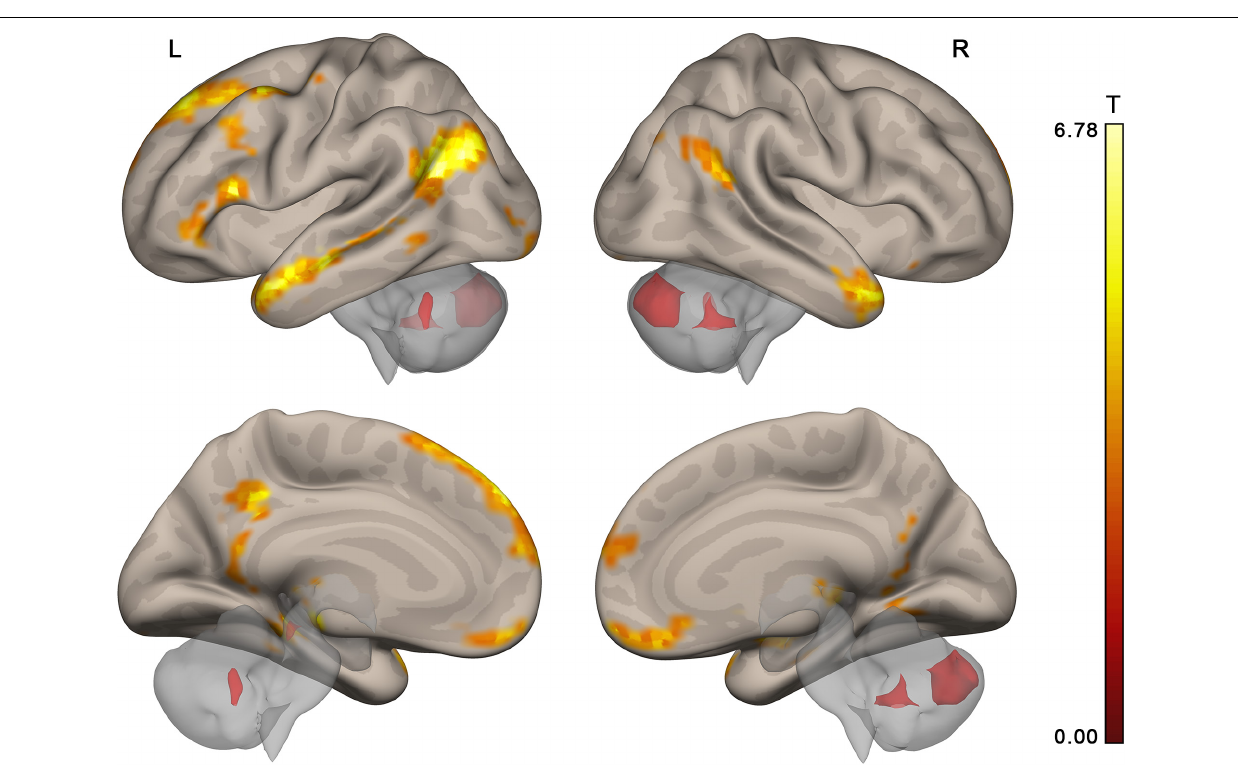
Frontiers in Human Neuroscience |